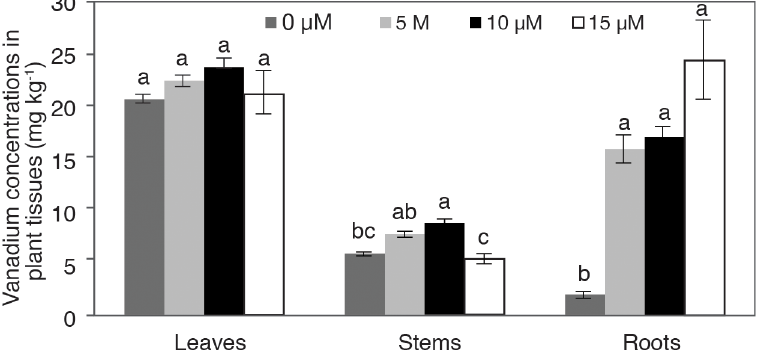
Fig 6. Vanadium (V) concentrations in leaves, stems and roots of pepper plants grown in nutrient solutions containing different concentrations of vanadium (0, 5, 10 and 15 μM V) during 28 days. Values are means ± standard error (SE) from at least five individual plants. Different letters above the bars for the individual plant parts indicate significant differences (Duncan, α = 0.05).